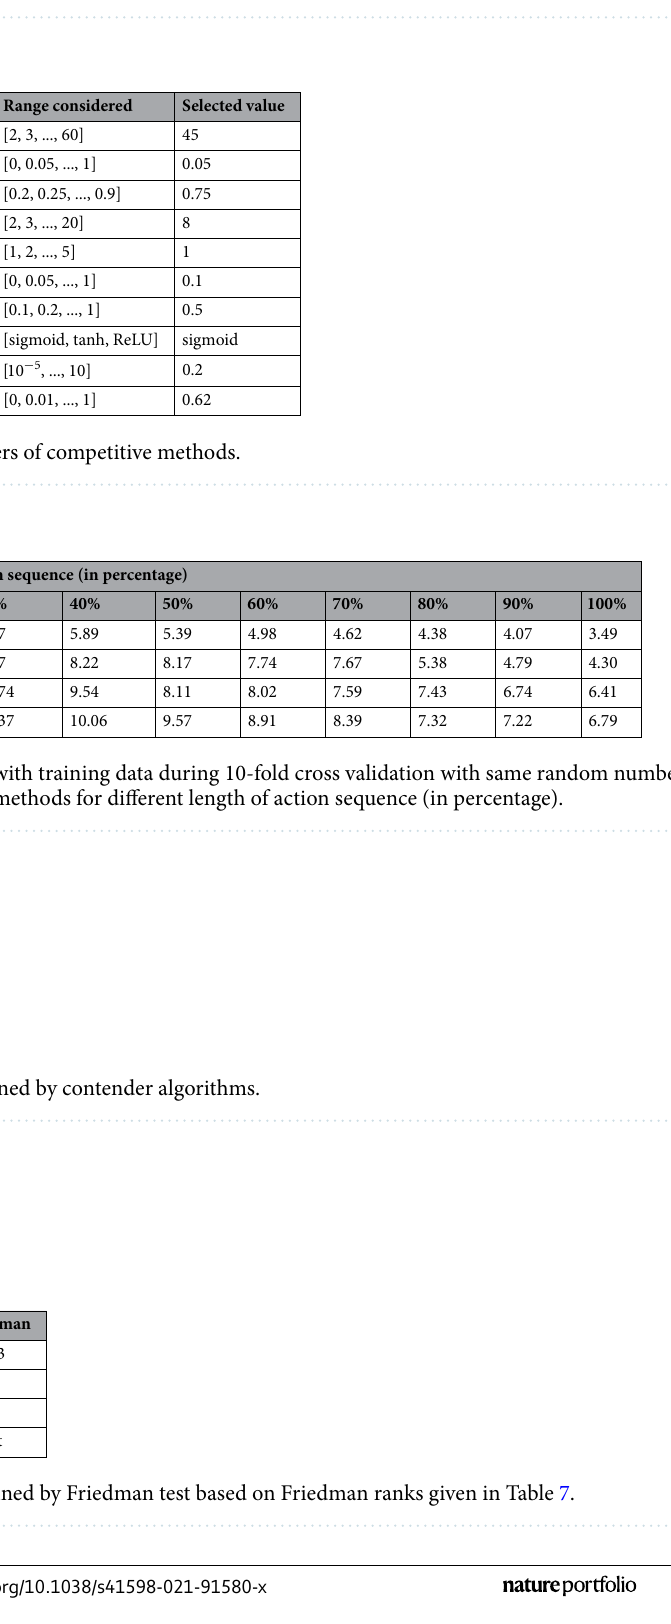
Table 4. Mean and standard deviation (STD) of MAPE values obtained by the proposed method over 20 experimental runs (each with 10-fold cross validation of training data) for different length of action sequence (in percentage per ).